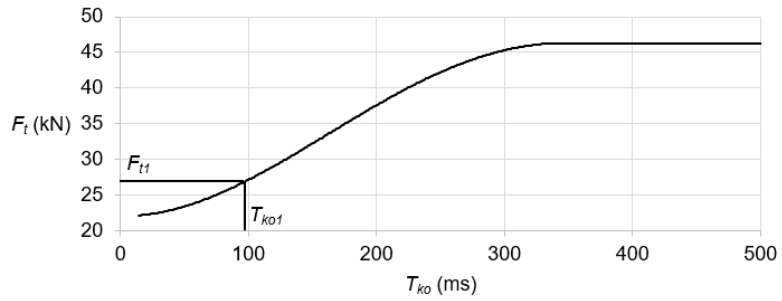
Figure 13. Force F t versus short circuit duration for I k ” = 40 kA.